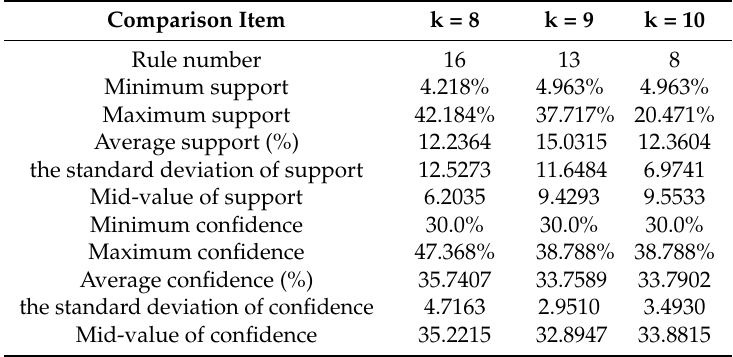
Table 8. Statistics comparison of association rules with different k values (the adjacent data segments